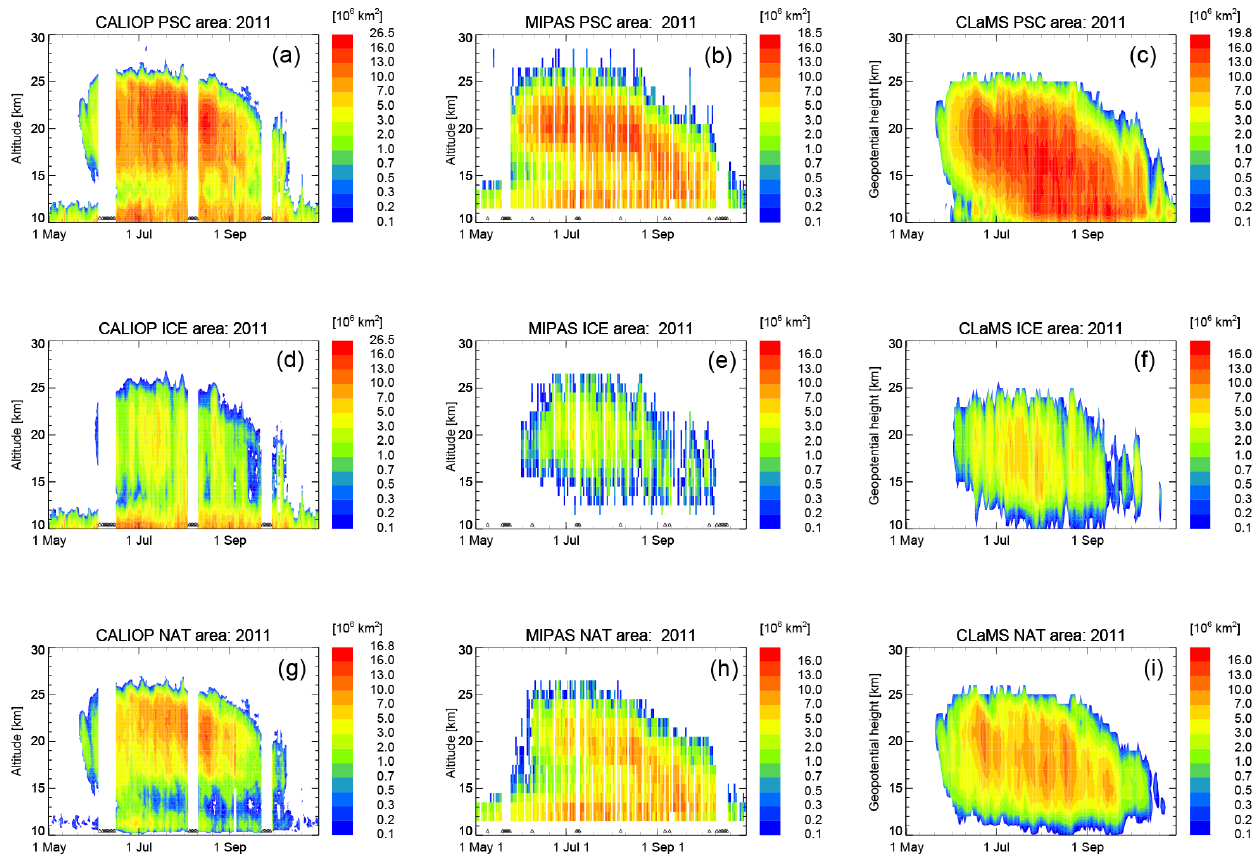
Figure 6. Same as Fig. 2 but for the 2011 SH winter from 1 May 2011 until 31 October 2011. Here, MIPAS observations and CLaMS simulations are restricted to latitudes < 82 ◦ S. Please note that the color code is always identical except for the maximum value of the top color